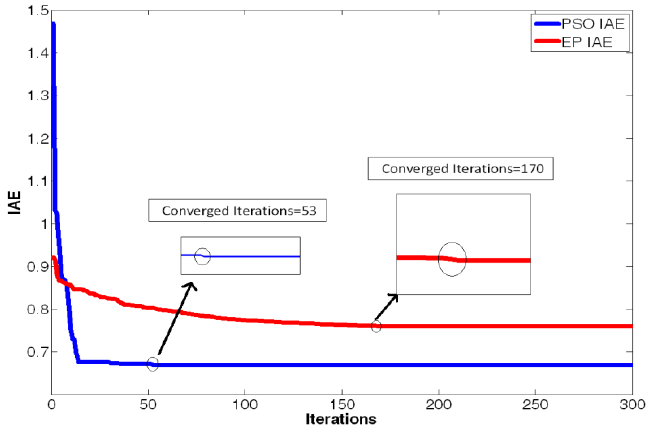
Figure 7. IAE convergence curve by PSO and EP with the initial conditions [xm1(0), xm2(0), xm3(0)] = [0.1, 0.1, 0.1] and [xs1(0), xs2(0), xs3(0)] = [ − 1, − 1, −